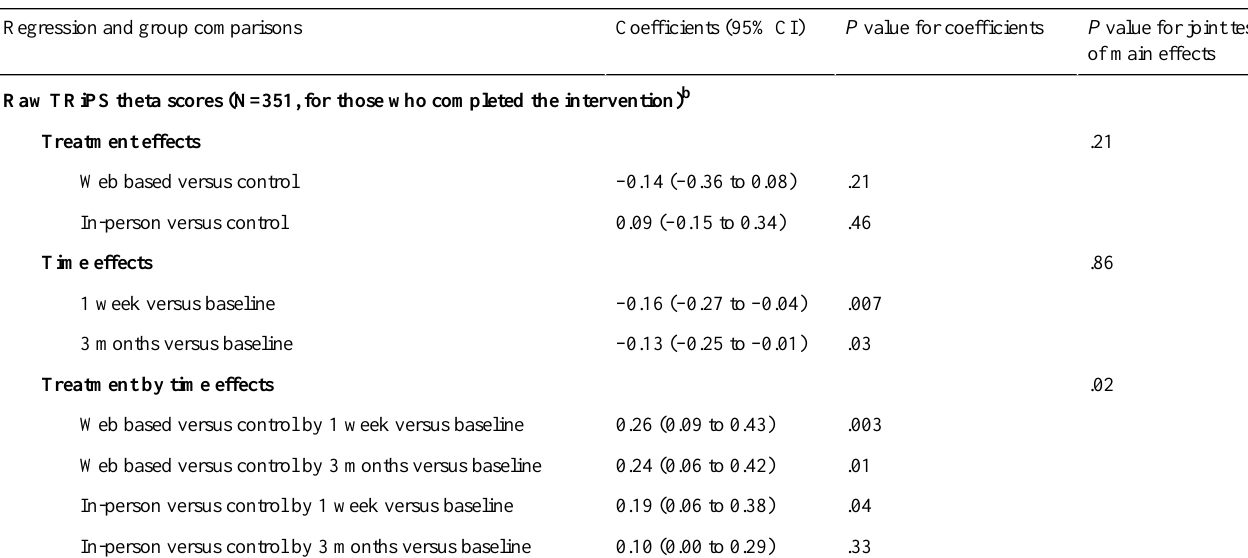
Intention-to-treat analysis (imputed TRiPS theta scores) (N=443, for those who were randomized to a condition and completed baseline